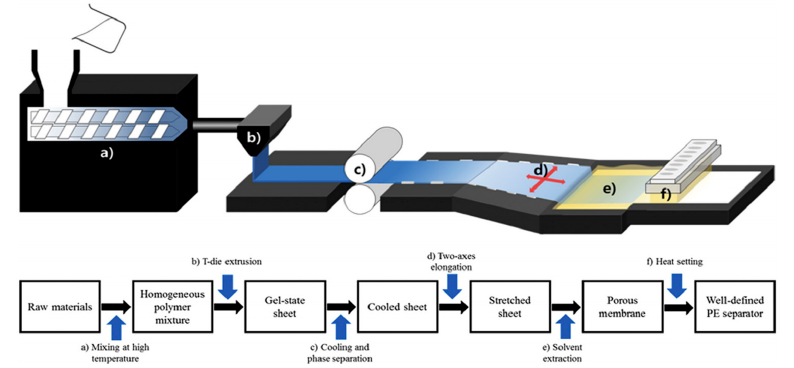
Figure 4. Schematic of typical PE separator wet manufacturing process with biaxial stretching. Reproduced with permission from [25].